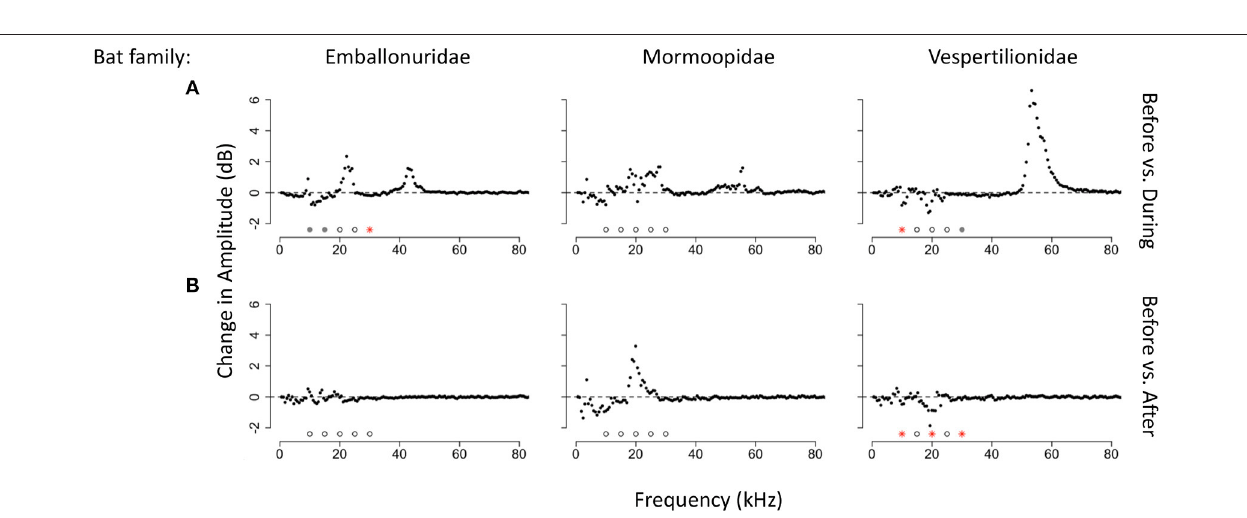
p = 0.040) and 30 kHz ( V = 1,464, p = 0.021) and a trend